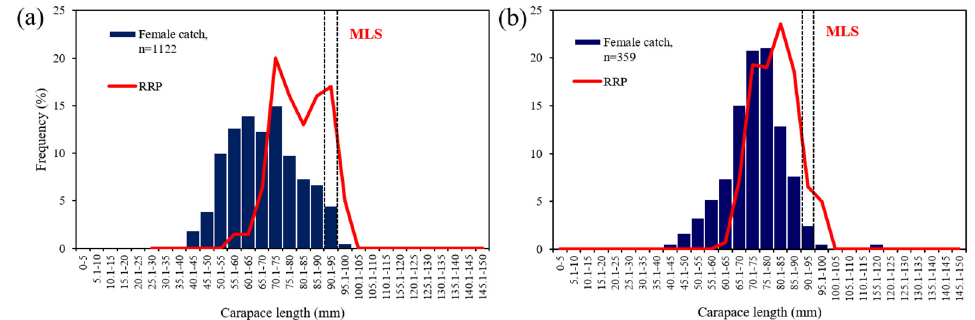
Figure 5. Relative reproductive potential (RRP) in relationship to carapace length plotted with the length–frequency distribution of the Palinurus elephas female catches in Su Pallosu ( a ) and Buggerru ( b ) FPAs. The dotted bar indicates the minimum legal size (MLS) of 90 mm CL.